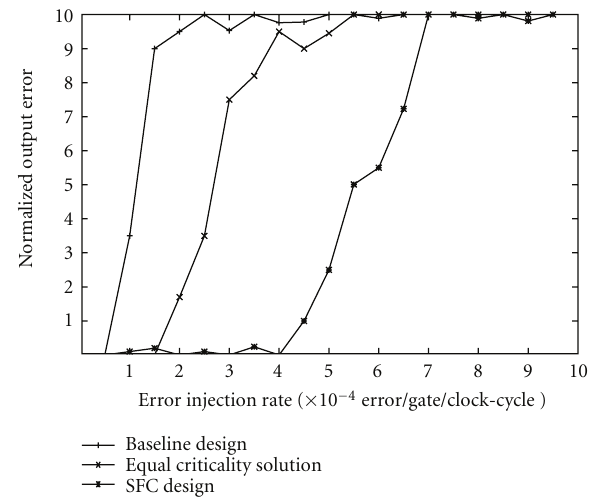
Figure 9: Error resilience comparison between baseline, equal criticality solution, and SFC design.